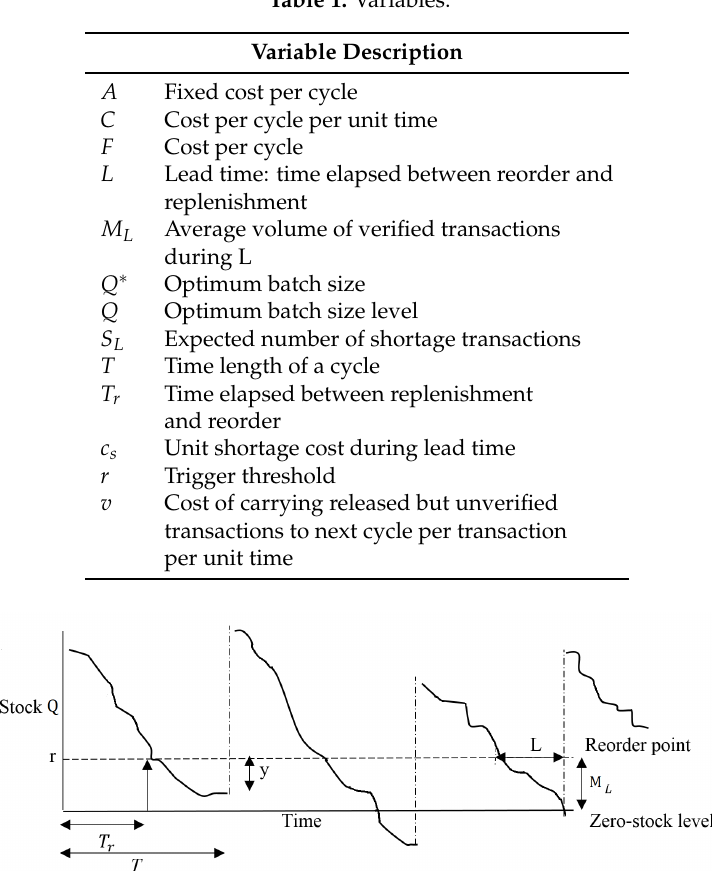
Figure 2. Q on the Y axis is the number of transactions to be verified while X axis is the time. T represents the time for a cycle. T r is the trigger time when r transactions are left unconsumed. The second plot shows a shortage situation. M L is the average consumption during L where T r + L = T